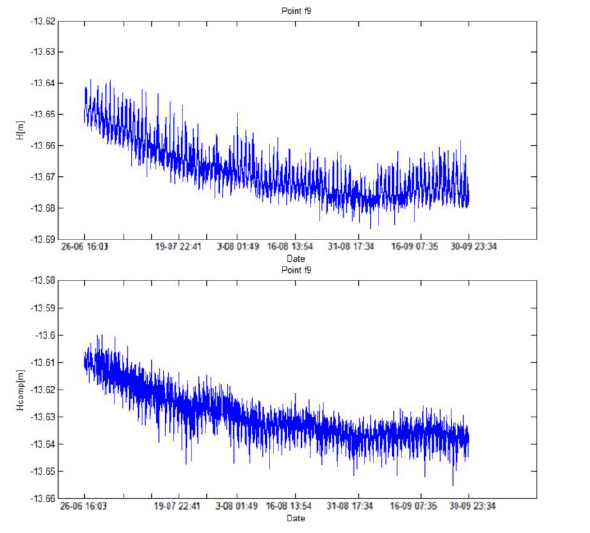
Figure 14. Envelope of the planimetric position obtained by raw data for point e2 (coordinates are referenced to the station)